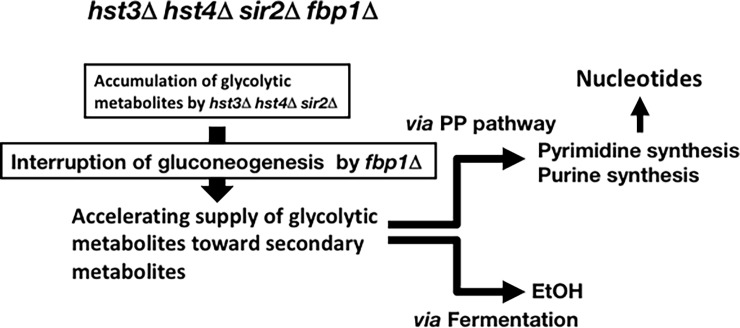
Schematic model to increase the levels of secondary metabolites in hst3Δ hst4Δ sir2Δ fbp1Δ cells.